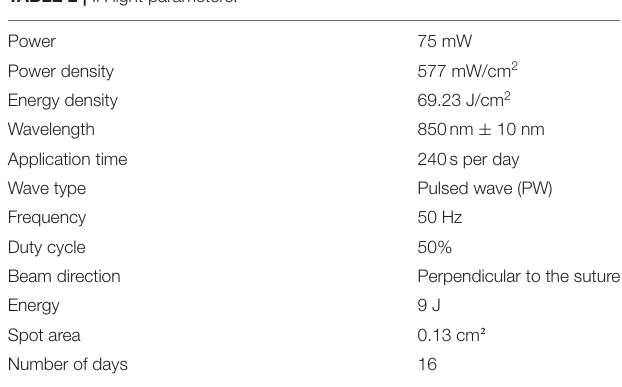
TABLE 2 | IR light